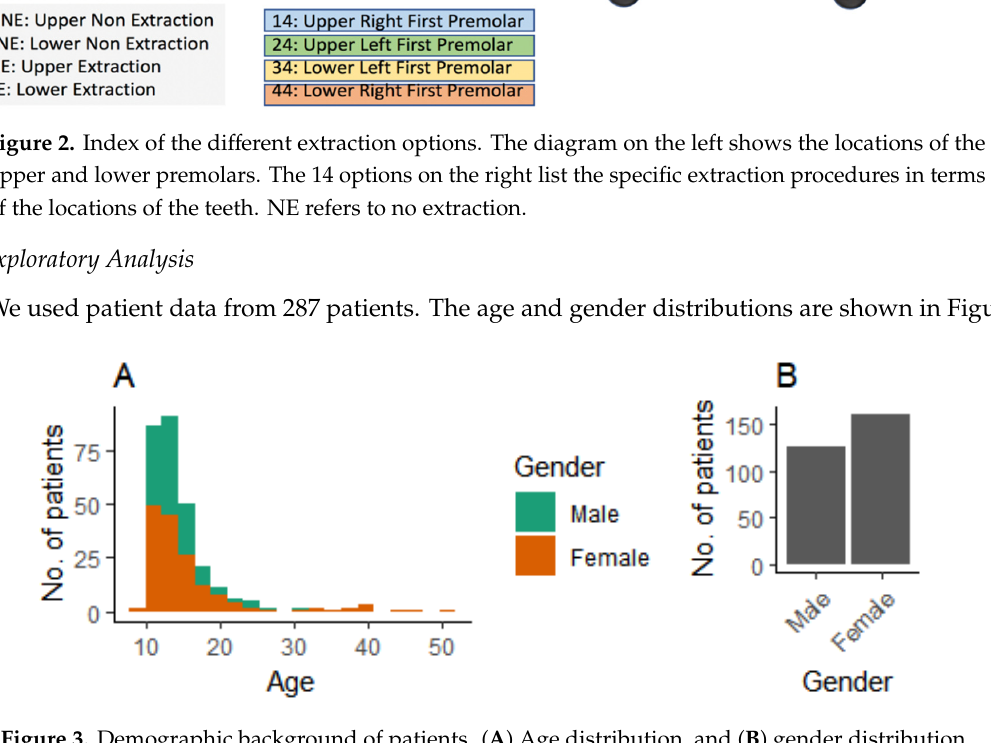
Figure 3. Demographic background of patients. ( A ) Age distribution, and ( B ) gender distribution.